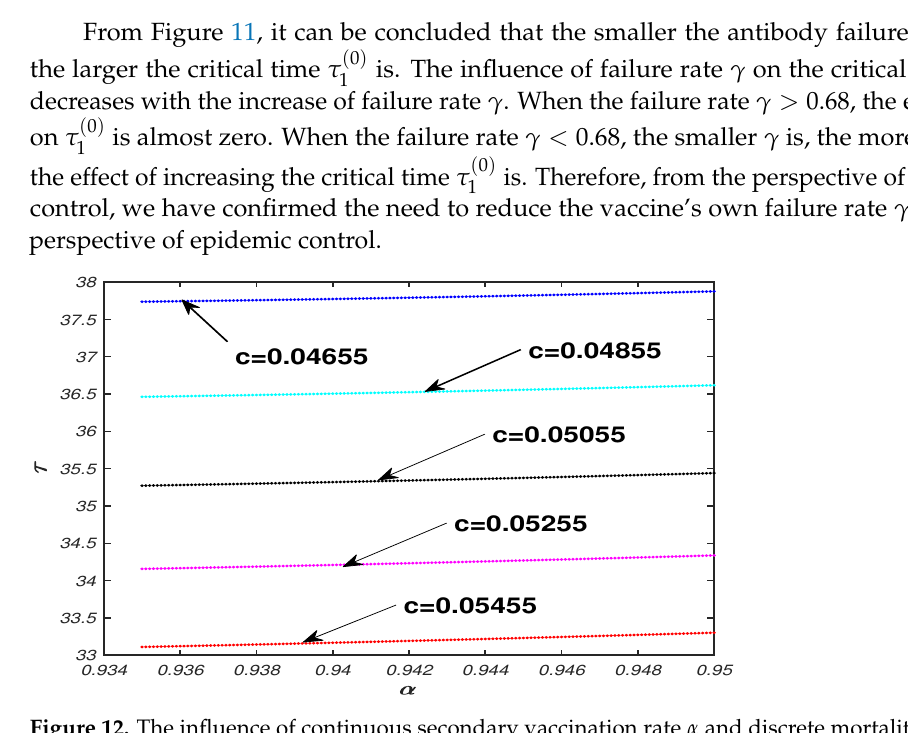
Figure 12. The influence of continuous secondary vaccination rate α and discrete mortality rate c on ( 0 ) the critical time τ 1